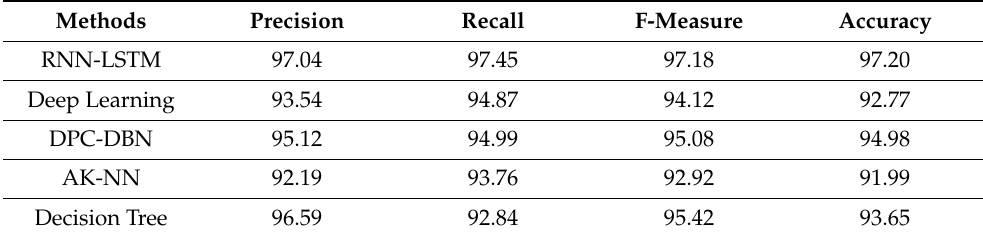
Table 6. Result Analysis of Existing with Proposed RNN-LSTM Method.